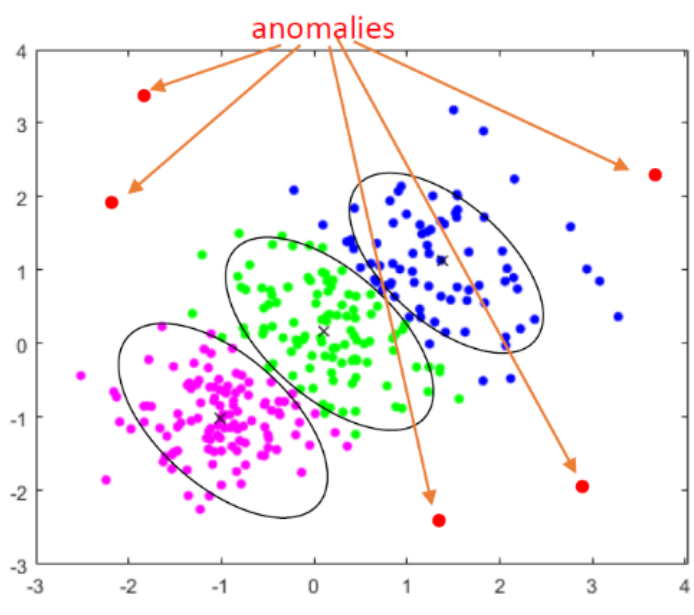
Fig. 5 Wavelet variance in different directions of farmland